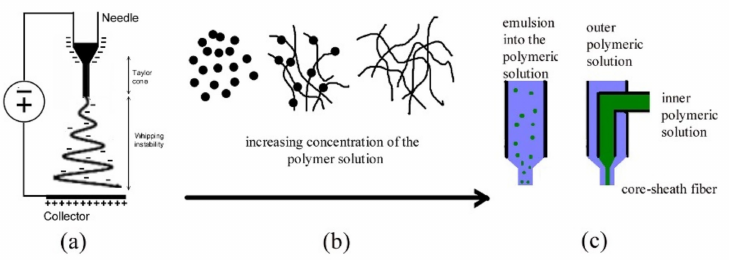
Figure 1. ( a ) Taylor cone and whipping instability in a typical electrospinning setup; ( b ) The same polymer can generate fibers (electrospinning) or droplets (electrospraying) depending on the viscosity of the solution; ( c ) emulsion versus coaxial